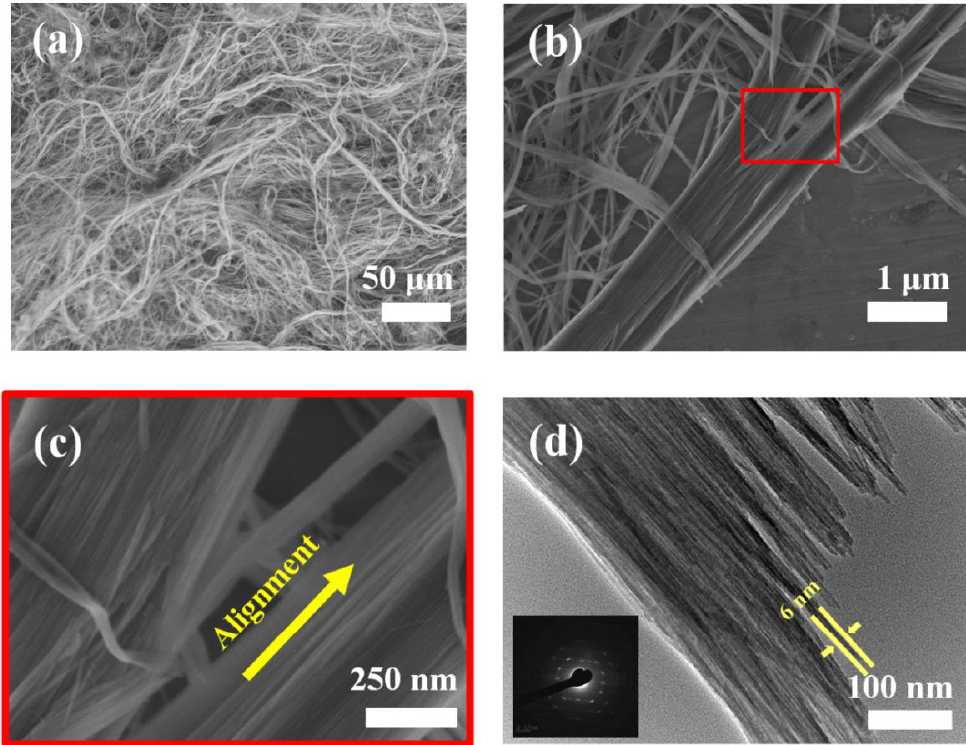
Figure 2. SEM images ( a – c ) and TEM image ( d ) of ultralong HAP nanowires synthesized by the calcium oleate precursor microwave hydrothermal method using ATP as a bio-phosphorus source in aqueous solution at 180 °C for 60 min; ( c ) is the enlarged SEM image in the area labelled with a red rectangle in ( b ); the inset of ( d ) is a selected-area electron diffraction pattern of ultralong HAP nanowires.